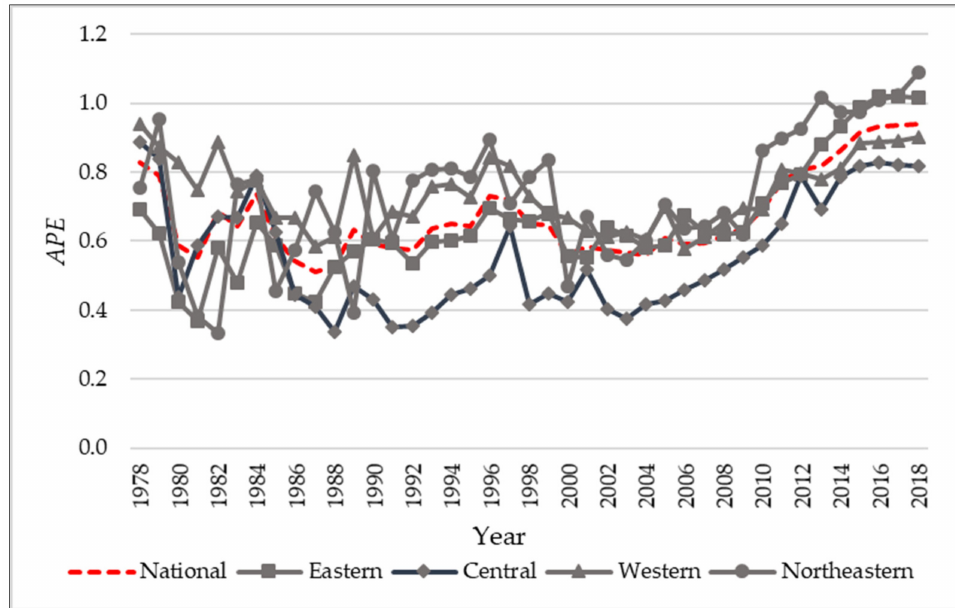
Figure 1. The trend of APE under dual constraints during 1978–2018. To further explore the differences in APE clustering evolving over time among provinces, a non-parametric Kernel density function of Gaussian distribution [49] was used, and six years, 1978, 1986, 1994, 2002, 2010, and 2018, were selected as observation time points for Kernel density estimation to obtain the distribution status at different time points (Figure 2). The height and width of the peak reflect the degree of agglomeration and the magnitude of differences in each province, respectively, and the number of peaks reflects the degree of polarization [50]. APE under dual constraints shows an overall “bi- modal” distribution from left to right and does not show polarization. It generally shows an upward trend but also has fluctuations. With the year 2000 as the dividing point, during 1978–2000, the height of the right peak has experienced the process of “falling and rising,” and the width first becomes large and then becomes small, indicating that APE showed a trend of fluctuations and the reduction in regional differences, consistent with the results of the aforementioned feature analysis. During 2000–2018, the height of the right peak increases and the width decreases, implying that APE stably improves and inter-regional difference gradually decreases. The overall APE under climate change shows a trend of first fluctuating and then stably increasing over time. Most provinces gradually change from “similar levels of high or low agglomeration” to high levels of agglomeration, and the gap among provinces in APE tends to